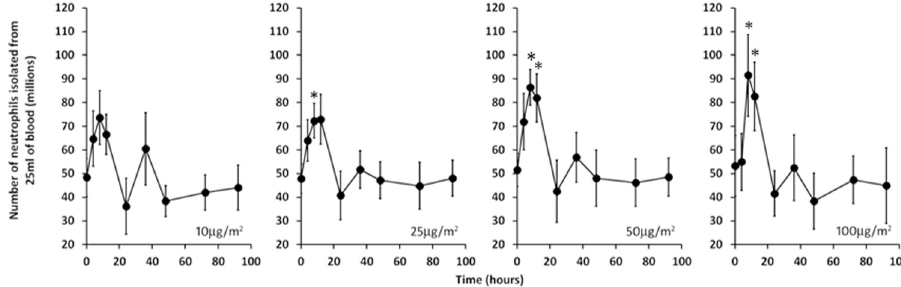
Fig 5. Elevated neutrophil yields are induced by IFN- γ . The indicated doses of IFN- γ were administered just after time 0 and the numbers of neutrophils isolated from 25ml of blood drawn at various times are shown. The error bars are SEM for n � 7. The asterisks indicate differences (p = 0.0087–0.0479) from time 0 (two tailed